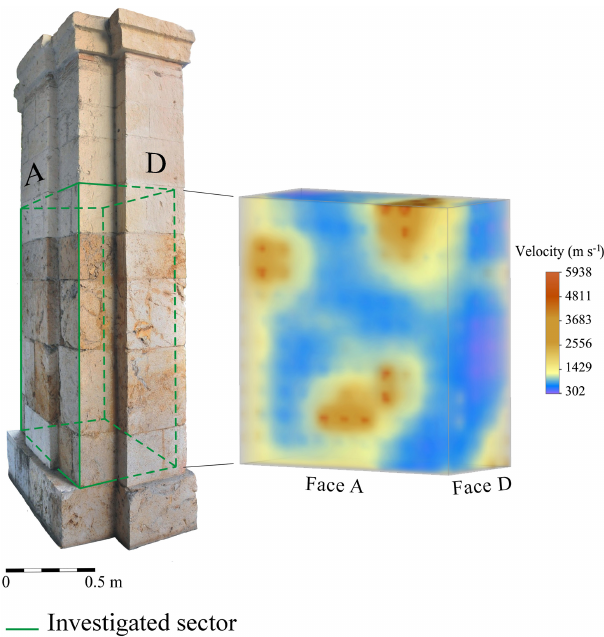
Figure 7. 3-D ultrasonic tomography results for the investigated sector of the